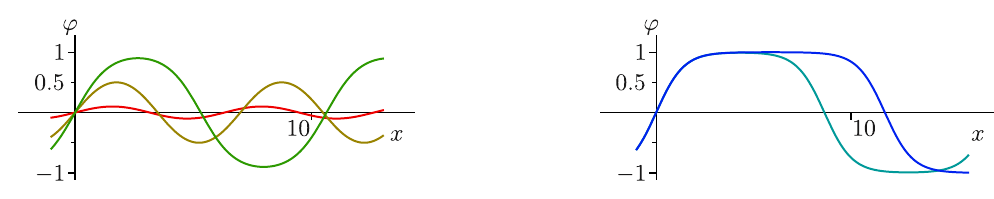
Figure 2.3: The elliptic sine configuration of Eq. (2.11), for different values of the amplitude parameter ϕ . The left figure contains solutions with (in order of increas- 0 = 0.1, ϕ = 0.5, and ϕ = 0.9. The right figure shows ing wave length) ϕ 0 0 0